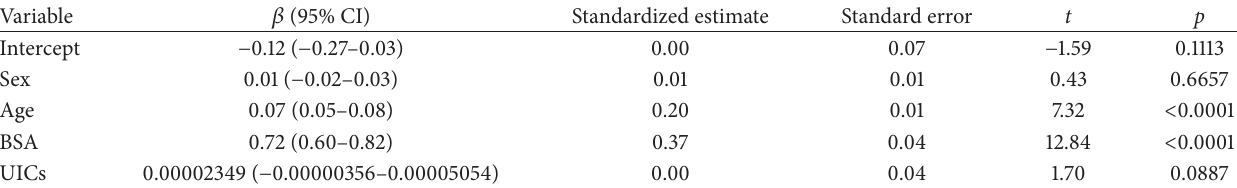
Table 3: Multivariate regression for thyroid volume in log scale as a function of sex, age, BSA, and UICs.